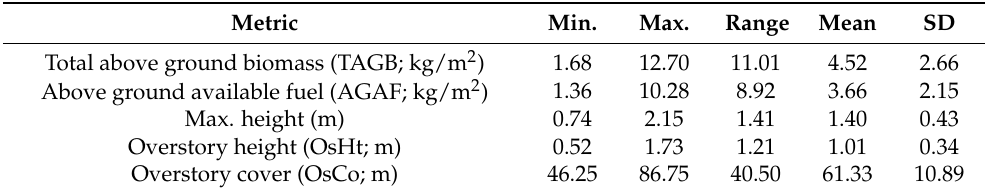
Table 1. Summary of destructive and non-destructive fuel characteristics of the field sample plots ( n = 16). Metric Min. Max. Range Mean SD Total above ground biomass (TAGB; kg/m 2 ) Above ground available fuel (AGAF; kg/m 2